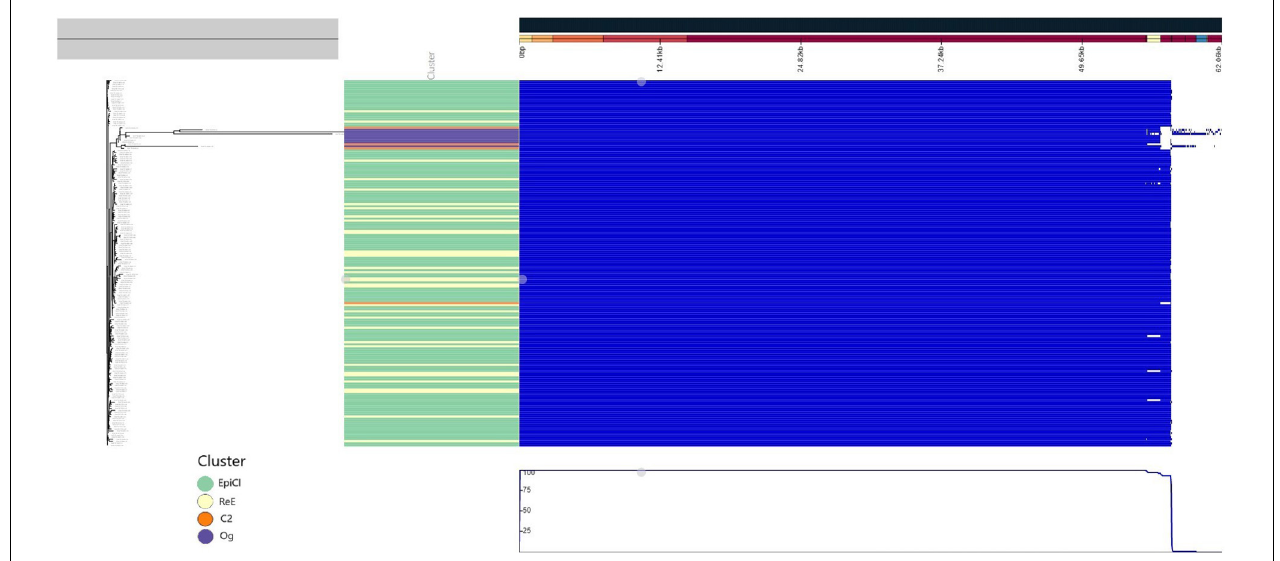
FIGURE 3 | Pangenome representation of all 186 L. monocytogenes isolates used in this study. The genes were considered present (blue color) or absent (white) based on Panaroo prediction using a 98% identity cutoff after annotation correction and coding sequence (CDS) realignment. The pan genome prediction was corrected using the maximum likelihood (ML) tree generated using the CFSAN pipeline. The metadata were colored in “Cluster” part according to the cluster (green for “Epi-Cl,” orange for “C2,” yellow for “Re-E,” and purple for